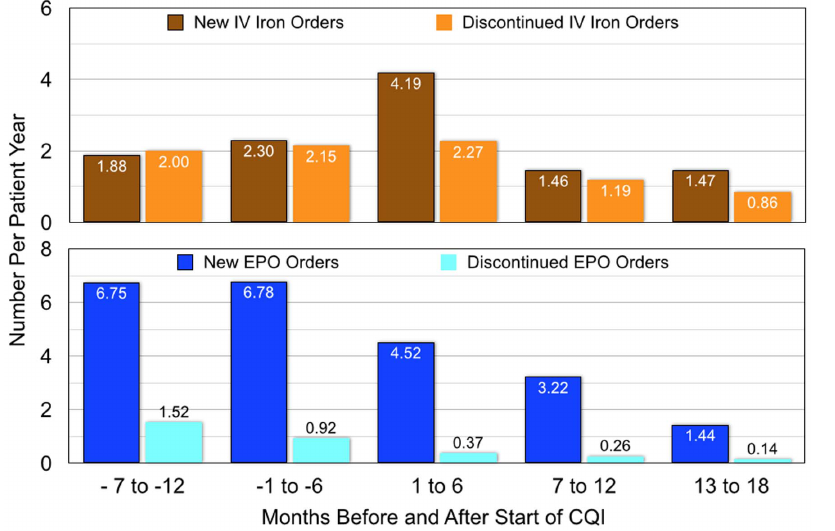
Figure 6. New orders and discontinued orders for IV iron and for EPO for two 6-month periods before and three 6-month periods after the start of the CQI